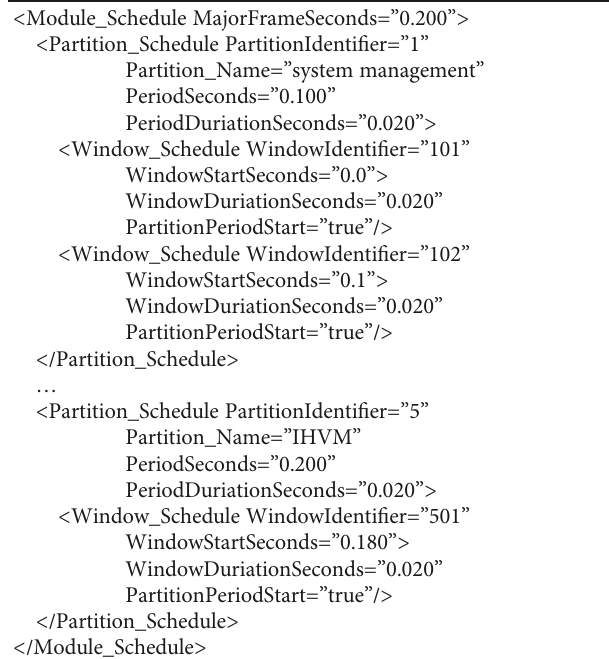
Table 13: Partition schedule con fi guration in XML